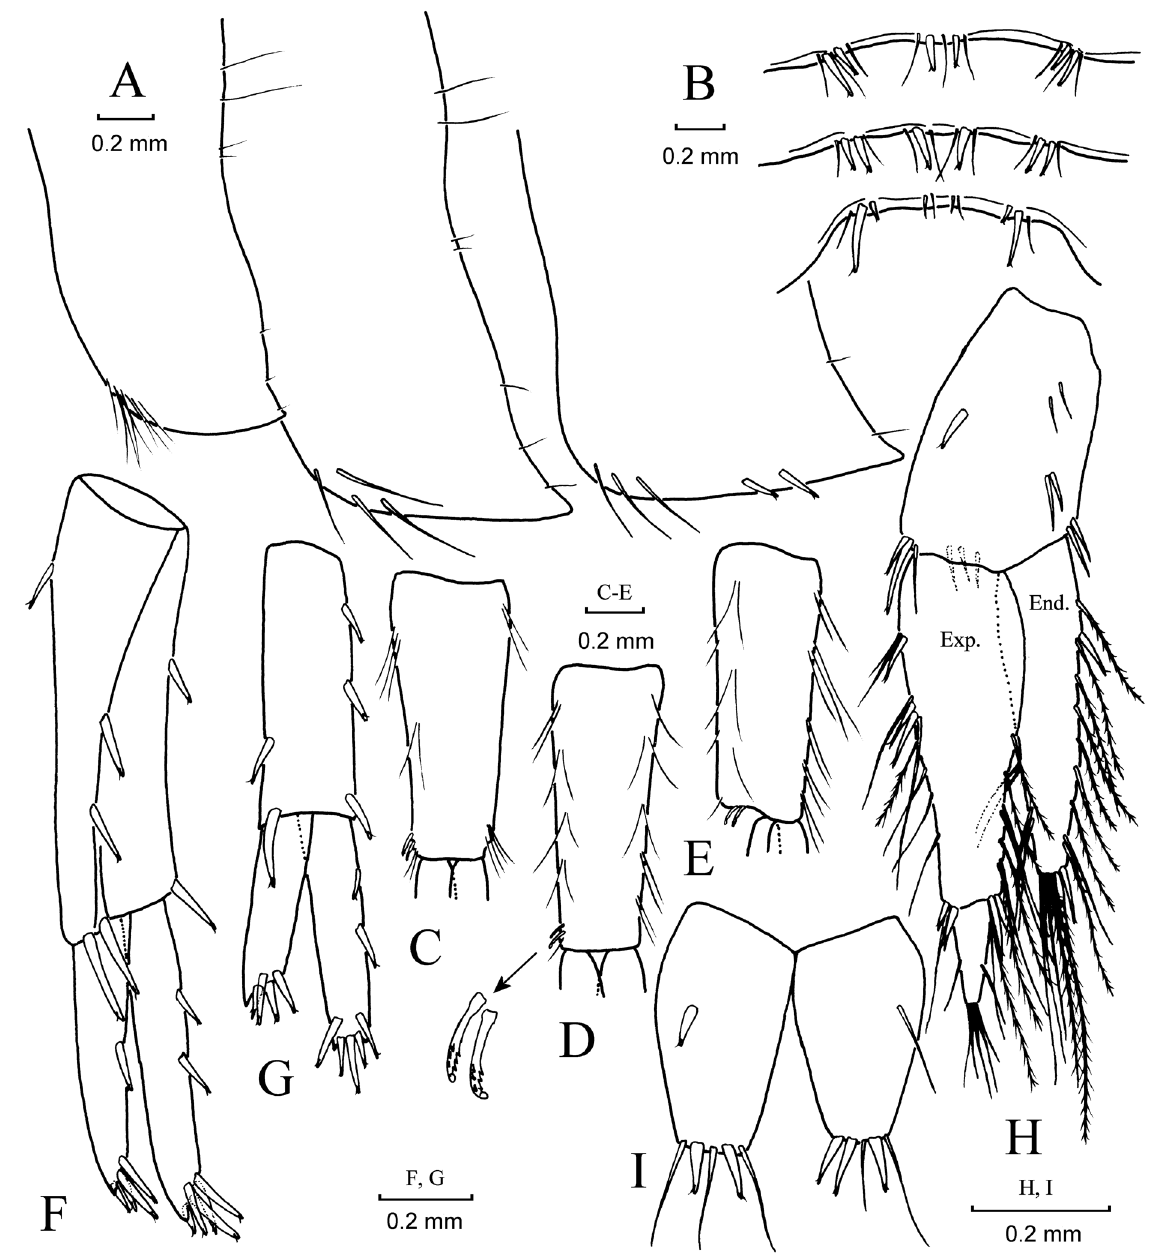
Fig. 5. Gammarus koshovi (Bazikalova, 1946), DAS 16-013, ♀, 8.0 mm. A . Epimeral plates I–III. B . Urosoma, dorsal view. C–E . Pleopods I–III (part.). F . Uropod I. G . Uropod II. H . Uropod III. I .